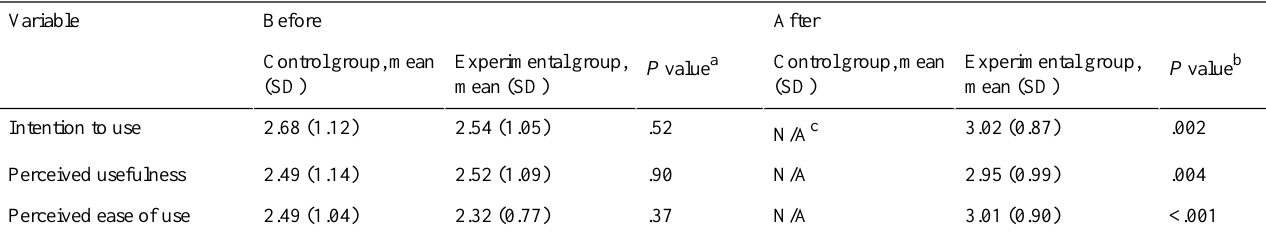
Table 5. Acceptability of the mHealth app by patients based on the Science and Technology Acceptance Model scale.